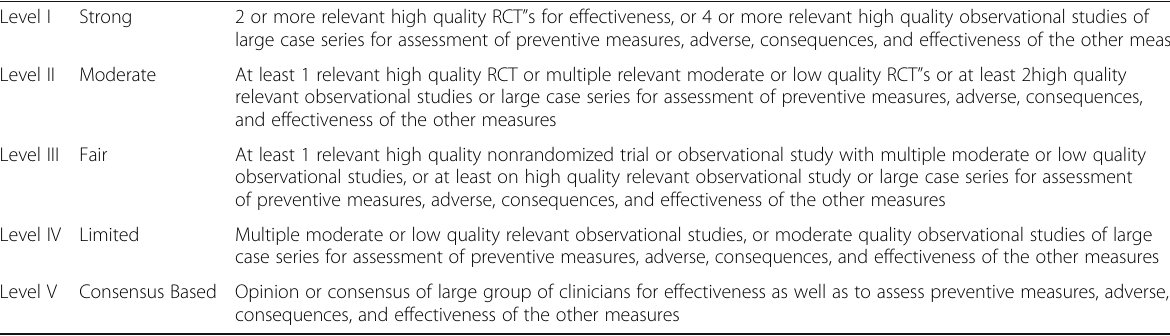
Table 1 Qualified modified approach to grading of evidence Level I